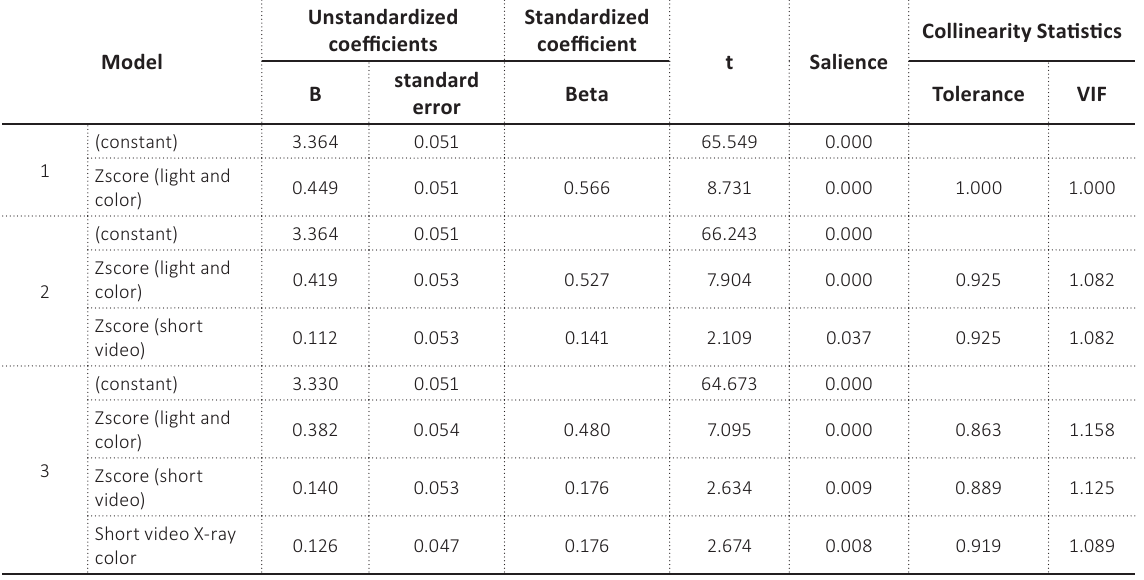
Table 9. Moderating effect